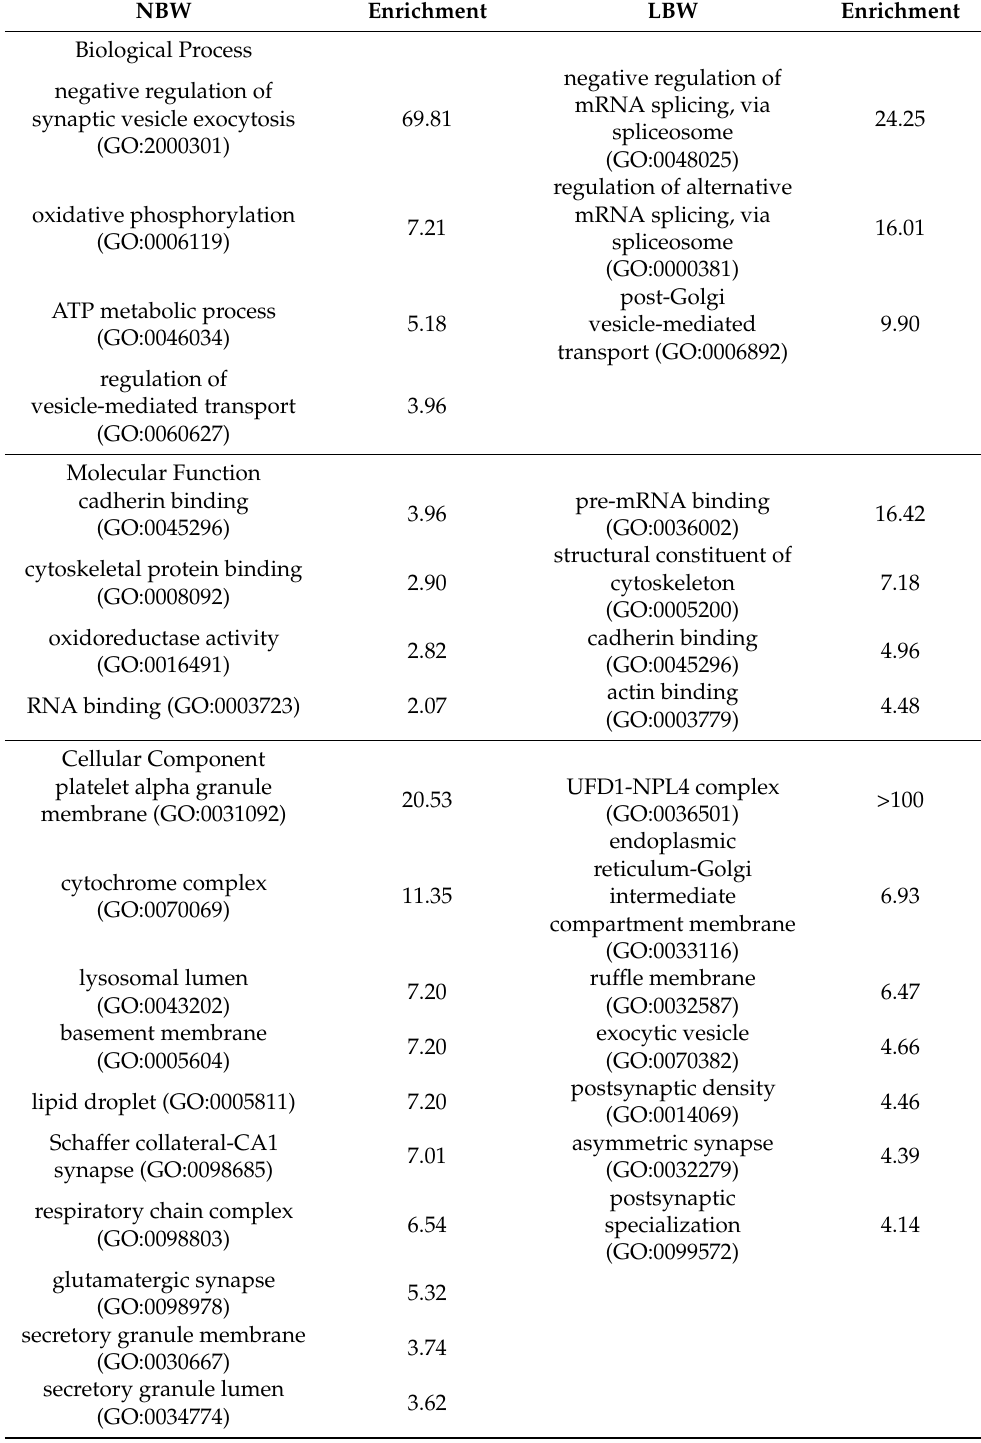
Table 3. Response of NBW and LBW animals to an HFD. Comparison between GO categories in NBW and LBW groups: Main categories from Panther have been selected and fold of enrichment indicated. Only main categories with the highest enrichment fold are